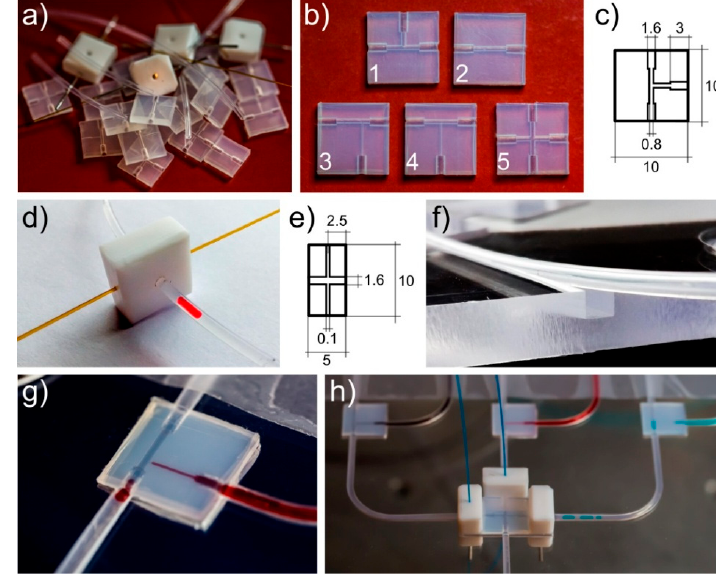
Figure 1. ( a ) Drilled/milled simple connectors, holding fibers and tubes. ( b ) Five different connectors: three T-junctions (1, 3, 4), a cross (X)-junction (5), and an adapter (2). ( c ) Dimensions of the T-junction unit. ( d ) The sensor cube that supports optical fibers connected with a light source and a photodetector designed for absorbance (optical density) measurements. ( e ) Dimensions of the sensor cube. ( f ) Polycarbonate frame (supporter) for the microfluidic system (support for tubing shown). ( g ) Assembled and operating T-junction—we used three tubes and one T-junction unit. ( h ) Droplet-on-demand section of the system that enables merging droplets from three T-junctions. Teflon holders (white drilled cuboids) support fibers to detect the position of a droplet to stop/switch the flow in the tubing at the appropriate time.